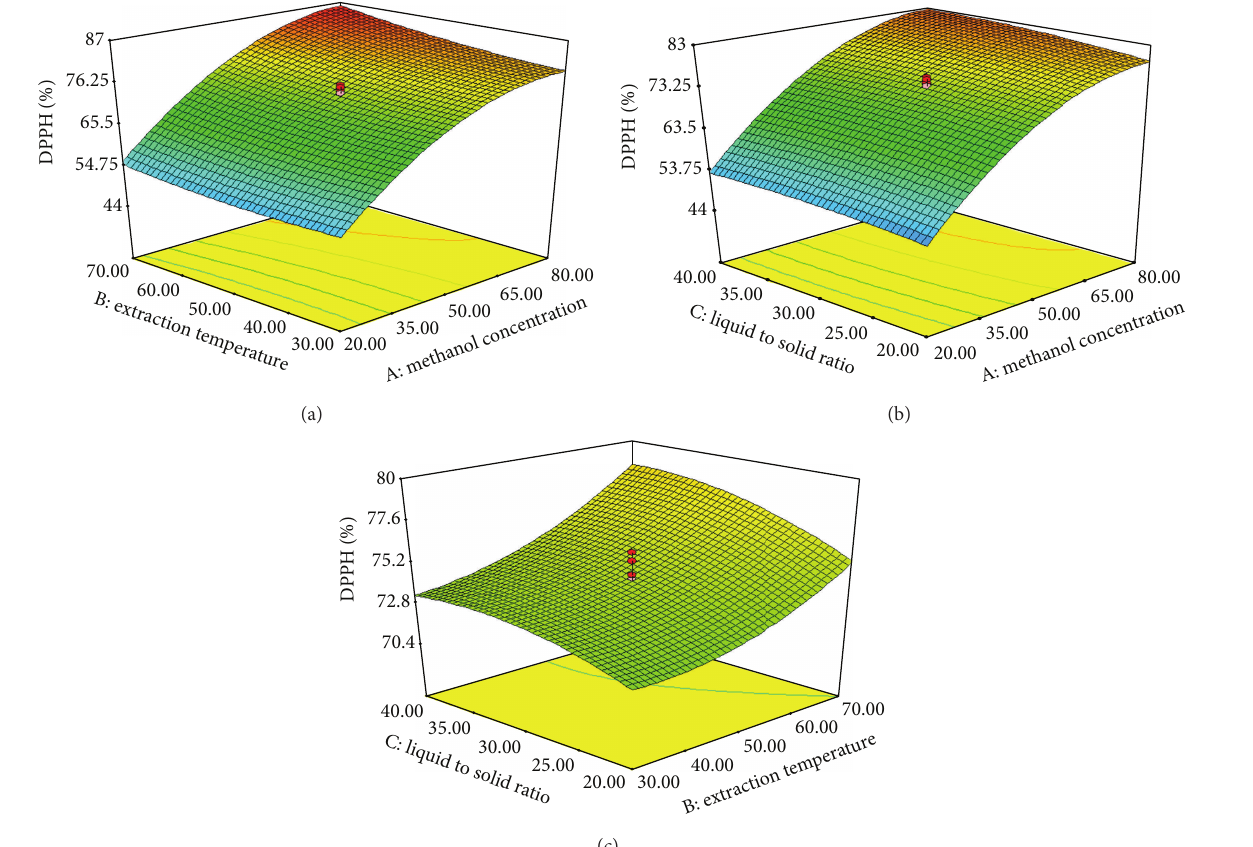
Figure 3: Response surface plots for the effects of MC (20–80%), ET (30–70 ∘ C), and LS ratio (20–40 mL/g) on the AC of Pandan extract. MC and ET (a), MC and LS ratio (b), and ET and LS ratio